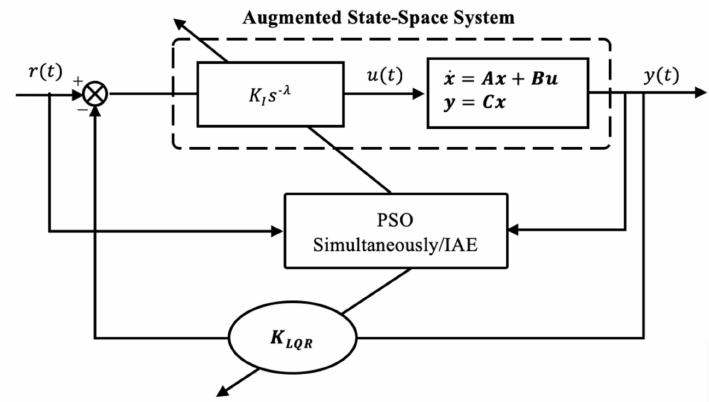
Figure 2. Proposed LQR-FIC controller